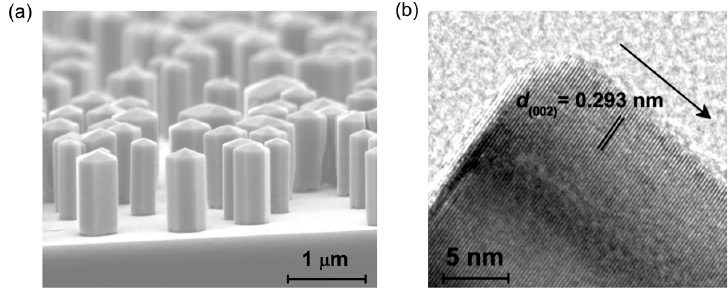
Figure 2. ( a ) SEM image of Mg-doped InN nanowires. ( b ) High-resolution TEM image taken from the root region of a single Mg-doped InN nanowire. The arrow denotes the growth direction [43].